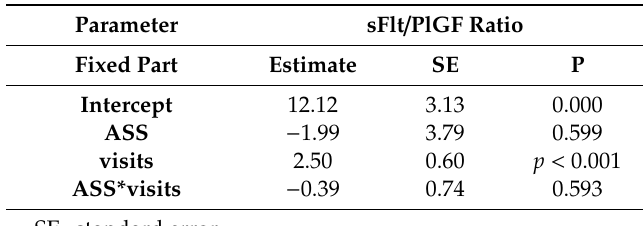
Table 5. Longitudinal changes of sFlt-1 / PlGF ratio during pregnancy.